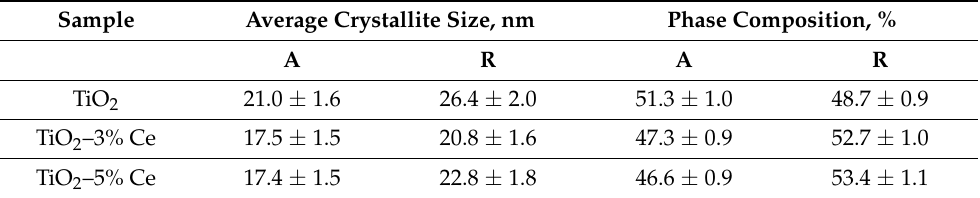
Table 2. Average crystallite size and phase composition of the fibrous TiO 2 and TiO 2 –x% Ce